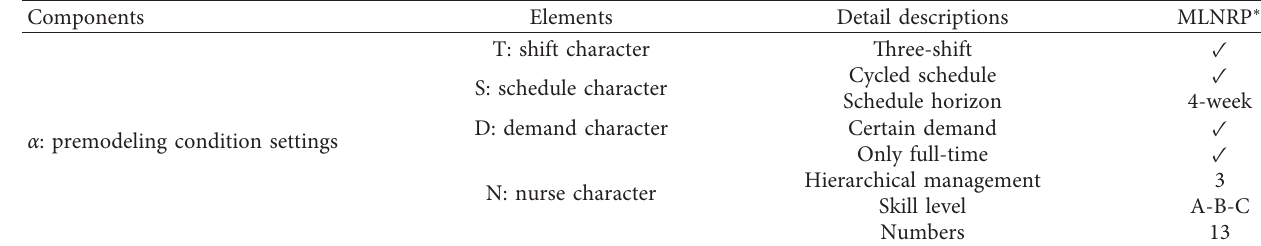
Table 2: Premodeling condition settings in MLNRP.